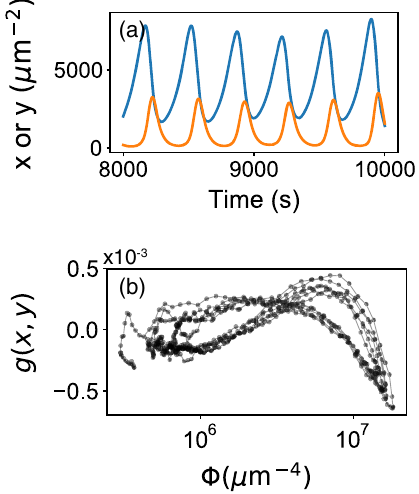
FIG. 8. Emergent concentration-dependent rates in the stochas- tic Lotka-Volterra equation: (a) A typical stochastic trajectory for α ¼ 0 . 01 s − 1 , β 0 ¼ 0 . 00001 μ m 2 s − 1 , and γ ¼ 0 . 04 s − 1 , x ð t ¼ 0 Þ ¼ y ð t ¼ 0 Þ ¼ 1000 μ m − 2 . The blue line represents prey concentration ( x ) and the orange line represents predator con- centration ( y ). (b) For this trajectory, we measure the covariance per unit Φ , g ð x; y Þ ¼ G ð x; y Þ = Φ vs Φ . g ð x; y Þ is the equivalent of κ ð Φ Þ − κ 0 , and it has a nonlinear dependence on the mass action Φ , which suggests that intrinsic noise can lead to concentration- dependent reaction